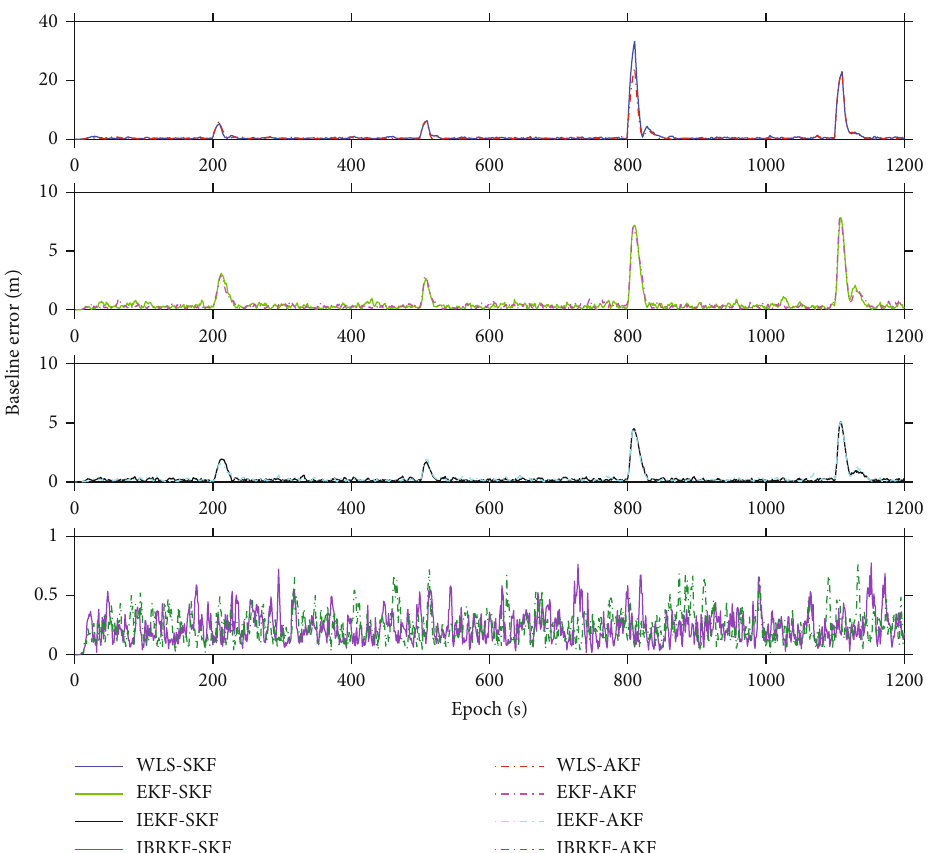
Figure 16: The baseline errors of various algorithms (Data